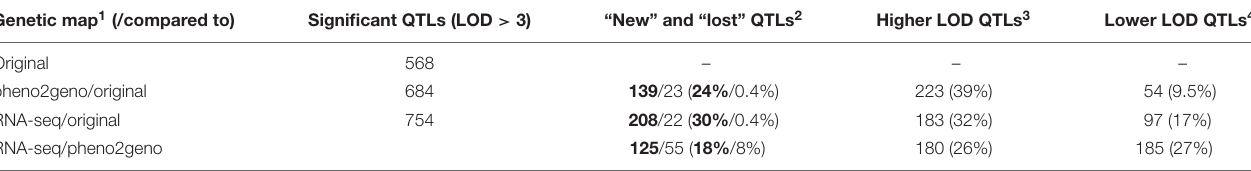
TABLE 3 | Comparison of LOD scores using the different maps.